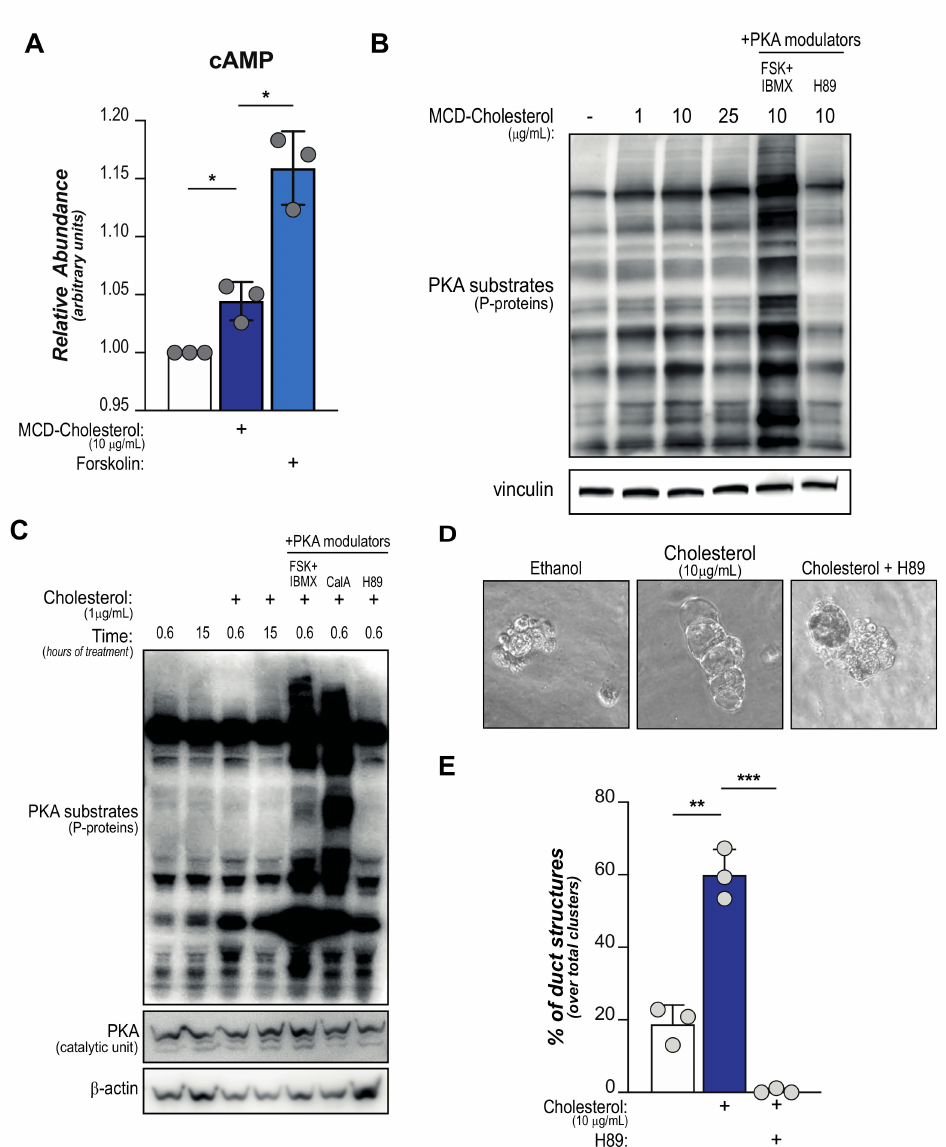
Figure 2. Cholesterol supplementation promotes PKA activation in pancreatic acinar cells. Pancreatic acinar cells were isolated from wild-type animals and supplemented with free- or MCD-bound-cholesterol at indicated concentrations. ( A ), cAMP levels were measured in independent acinar explants ( n = 3). Forskolin was used as positive control. *, p < 0.05. ( B , C ), Western blotting shows PKA-specific phosphorylation sites in acinar cells treated ( B ) with increasing concentrations of cholesterol or indicated compounds for 40 min or ( C ) with minimal cholesterol for extended times (indicated). In ( C ), total PKA abundance is also shown. ( D , E ), Pancreatic acinar cells were isolated from wild-type mice ( n = 3), embedded in a synthetic hydrogel cast and stimulated with recombinant EGF (100 ng/mL). Cells were treated with free cholesterol (10 mg/mL) ± H89 or vehicle. After 5 days, morphology of cellular clusters was examined. Representative images are shown in D, blinded quantification of duct-like structures in E. *, p < 0.05; **, p < 0.01; ***, p < 0.001. For all panels, FSK: forskolin (20 µ M); CalA: caliculin-A (5 µ M); H89: N-[2-p-bromocinnamylamino-ethyl]-5-isoquinolinesulfonamide (30 µ